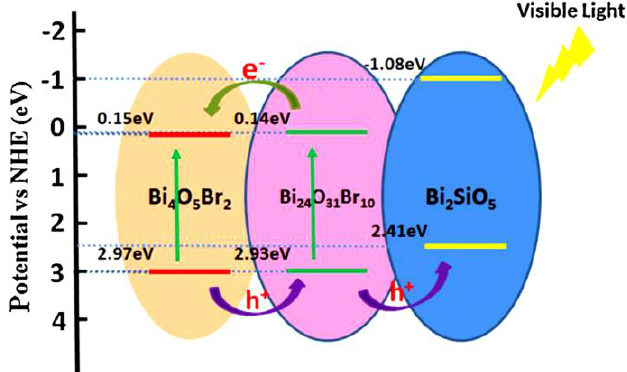
Figure 8. Schematic illustration of the band-gap structure and possible flow of charge carriers through the ternary heterostructure under visible light irradiation. Reproduced with permission from [113]. Copyright 2015 Elsevier.